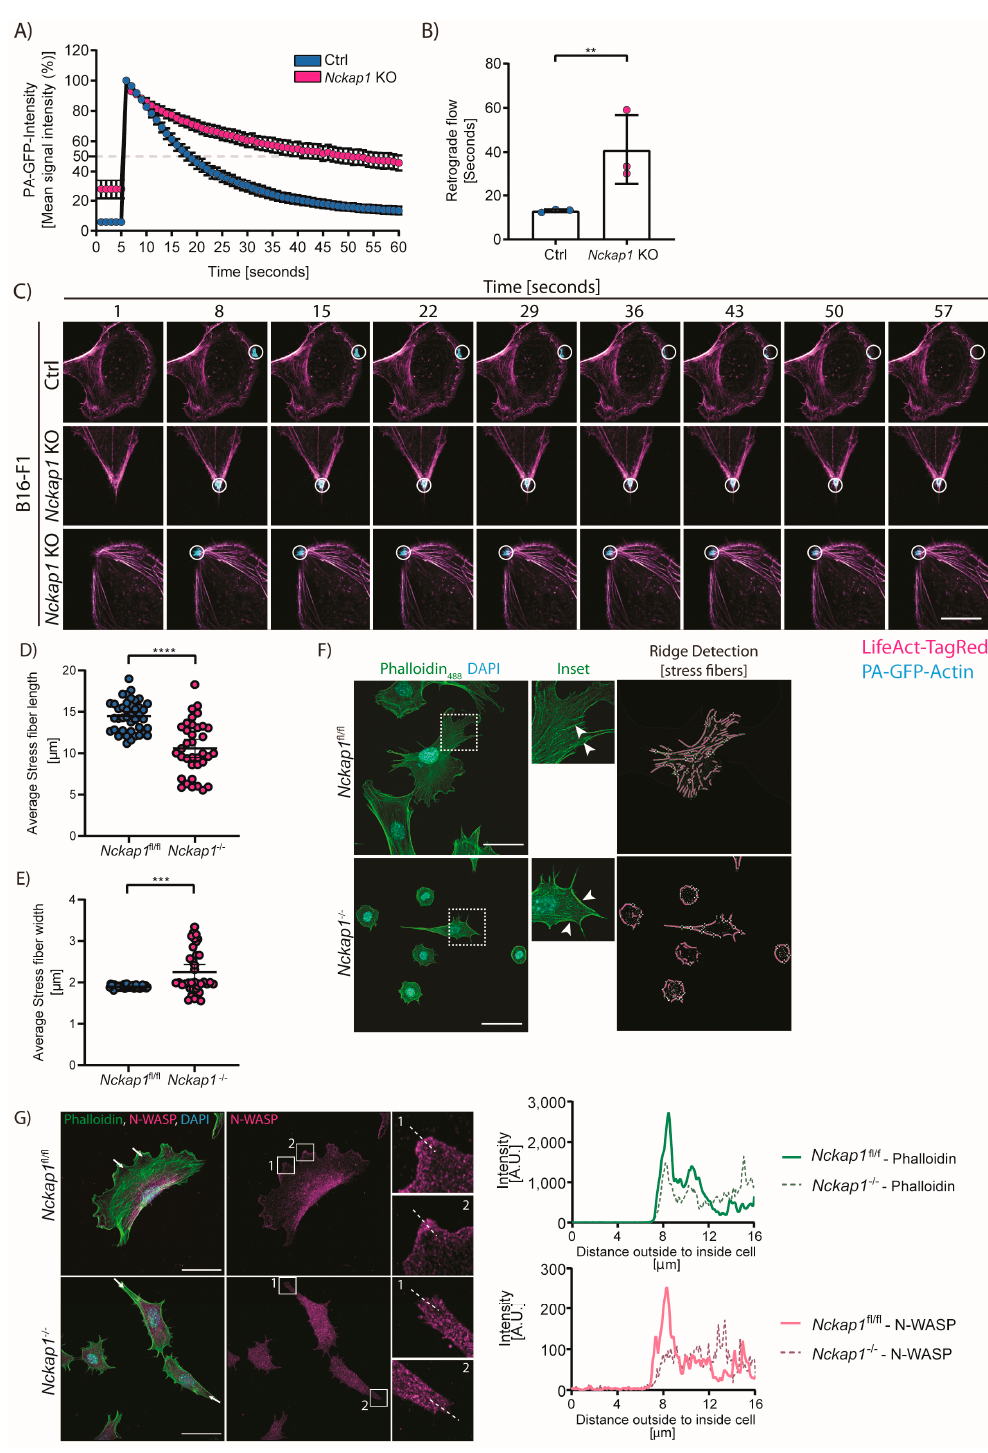
Figure 2. Deletion of Nckap1 alters the actin dynamics. ( A – C ) Retrograde flow analysis in the control and Nckap1 CrispR B16-F1 cells transfected with PA-GFP-Actin. ( A ) Quantification of PA-GFP-Actin signal intensity showing pre-bleach (the 5 s prior to activation), 100% (activation) and consequent intensity decay. The 60 cells were analysed over n = 3 independent experiments. Error bars represent 95% C.I. The dashed line is set at 50%. ( B ) Actin lifetime is expressed as t 1 / 2 of intensity decay from ( A ). n = 3 independent experiments are shown. Error bars represent S.D. Statistical significance was assessed by a two-tailed t -test, ** p < 0.01. ( C ) Representative images showing PA-GFP-Actin